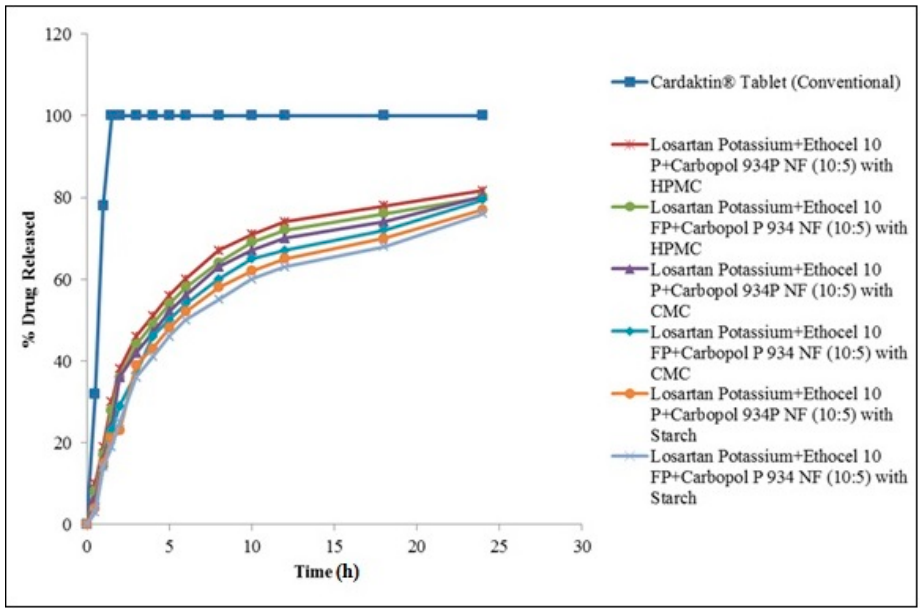
Figure 2. Drug release from polymeric matrices when co-excipients were added. The points in the curves indicate the mean value of three repetitions.